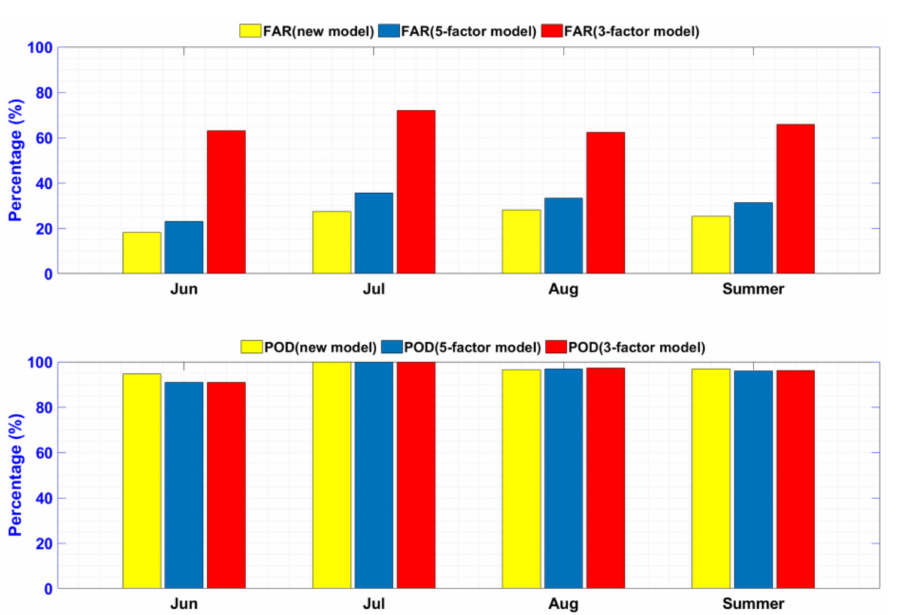
Figure 8. Comparison of the probability of detection (POD) and high false alarm rates (FAR) scores of predictions from the new model and the monthly models (five-factor model and three-factor